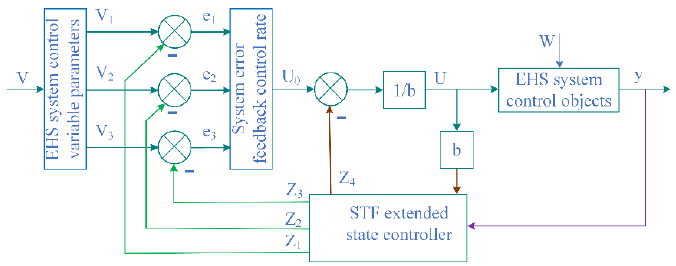
Figure 8. Designed block diagram of the proposed SAD third ‐ order controller.